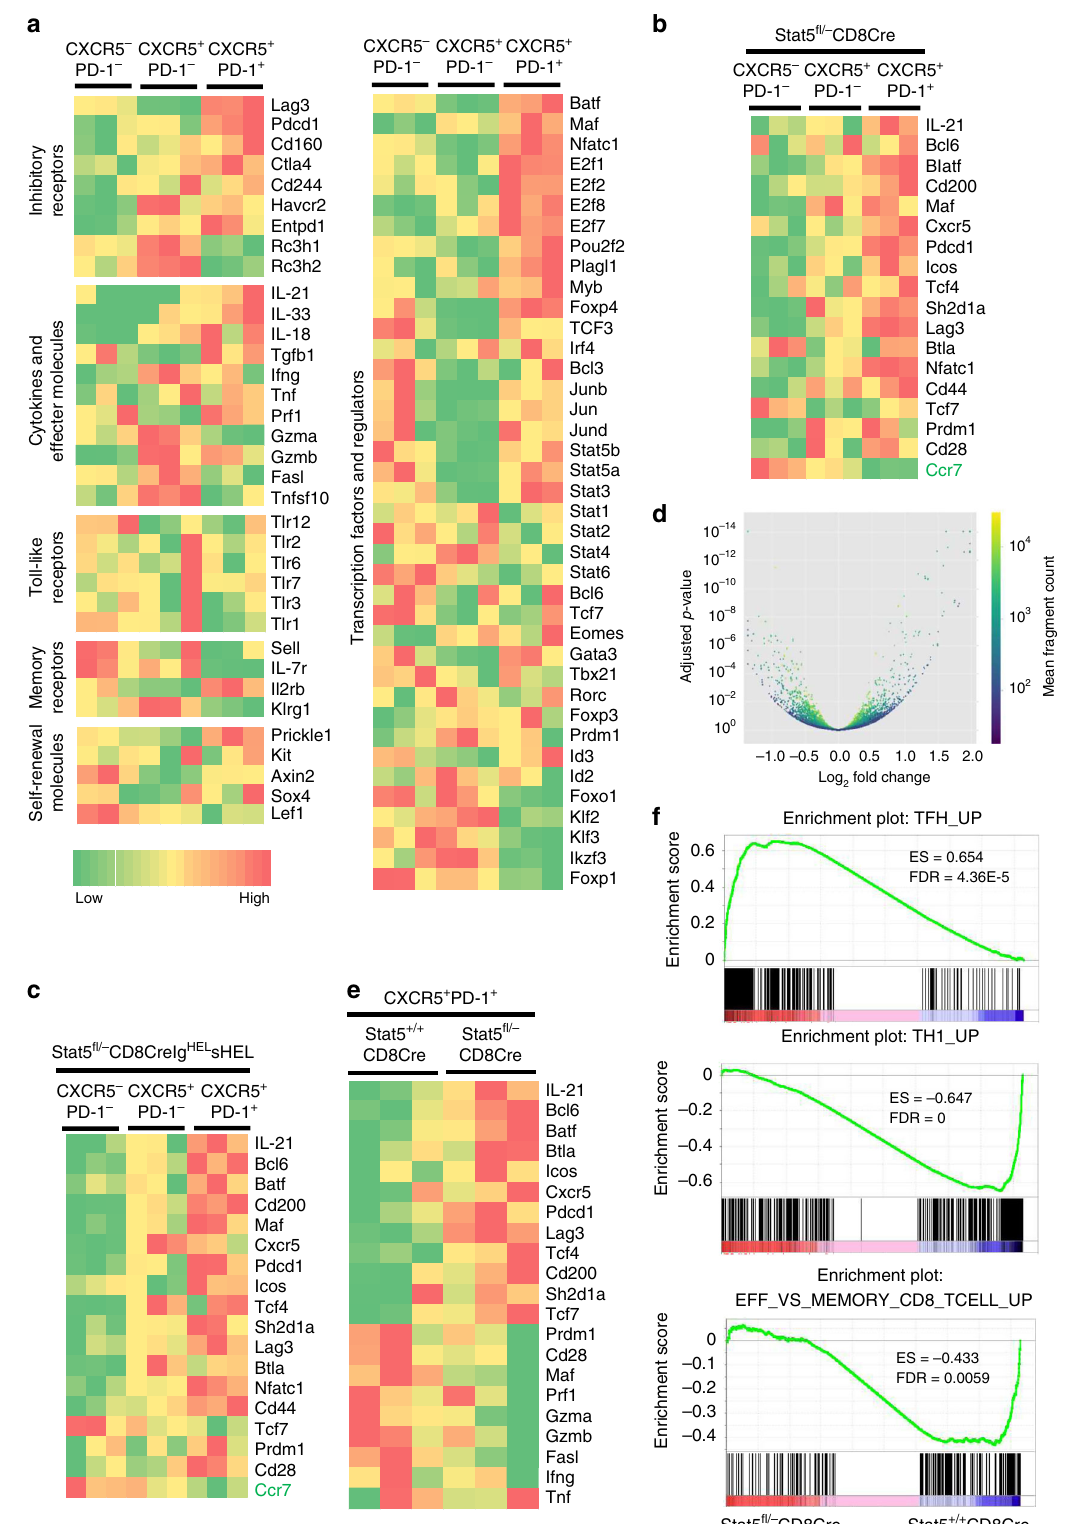
for effector CD8 T-cell differentiation (Fig. 6d and Supplemen- tary Figs. 14, 15) 52,53 . The CD4 + Tfh-related genes, such as Icos , Maf and Pdcd1 , were expressed at similar levels between the clusters 1 and 2 (Supplementary Figs. 14, 15). Among the three very minor populations, cluster 4 expressed CD8 + memory